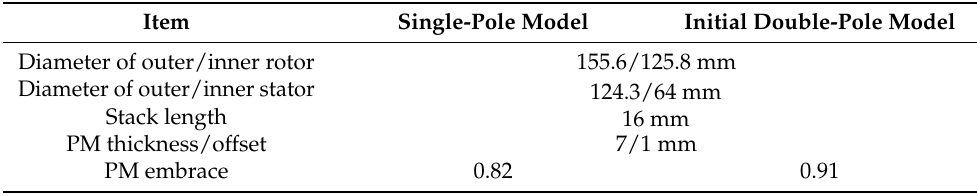
Table 2. PM (permanent magnet) specification. Table 1. Dimensions of the analysis motor.